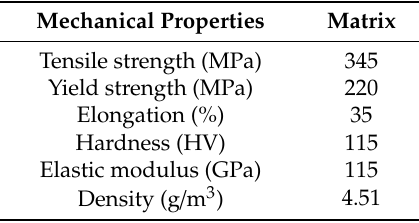
Table 2. Mechanical properties of β -titanium